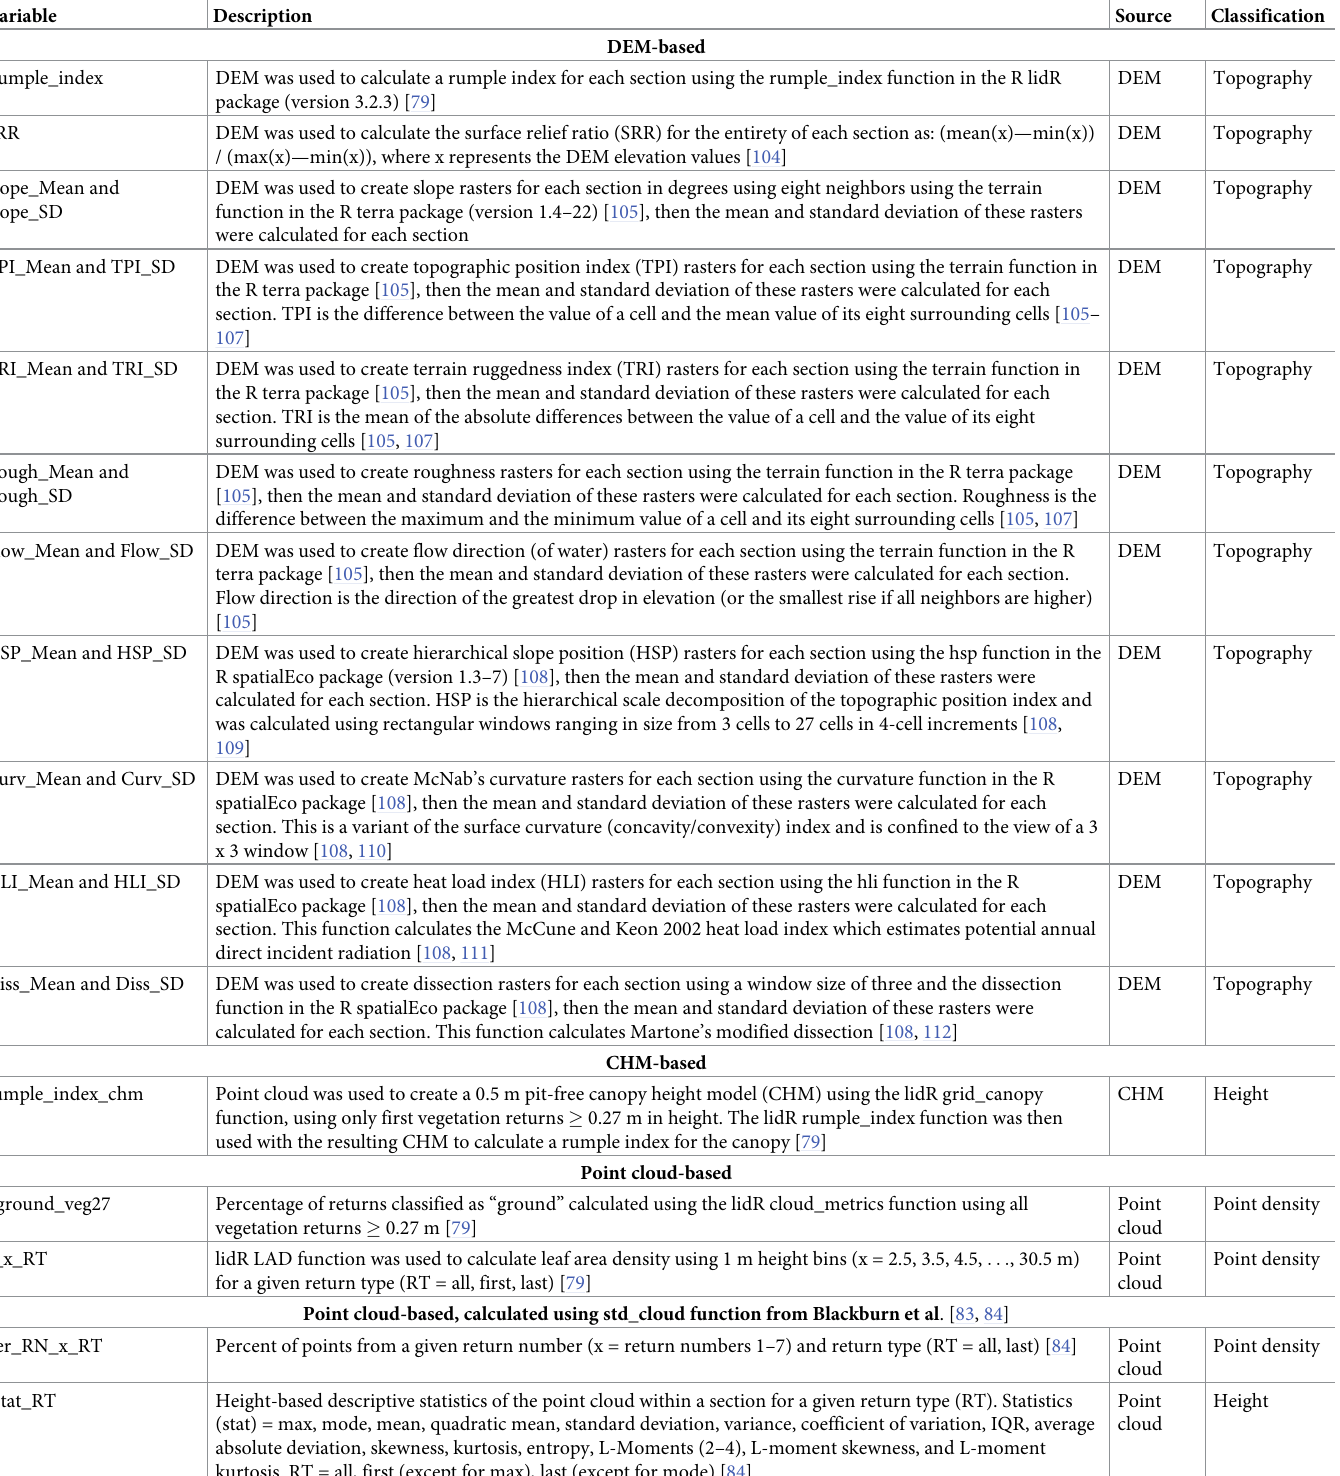
Table 1. Lidar DEM-, point cloud-, and voxel-derived metrics. RT: all = all vegetation returns � 0.27 m; first = first vegetation returns � 0.27 m; last = last vegetation returns � 0.27